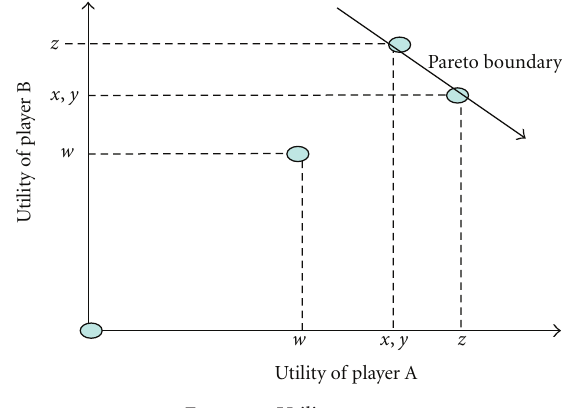
Figure 7: Utility